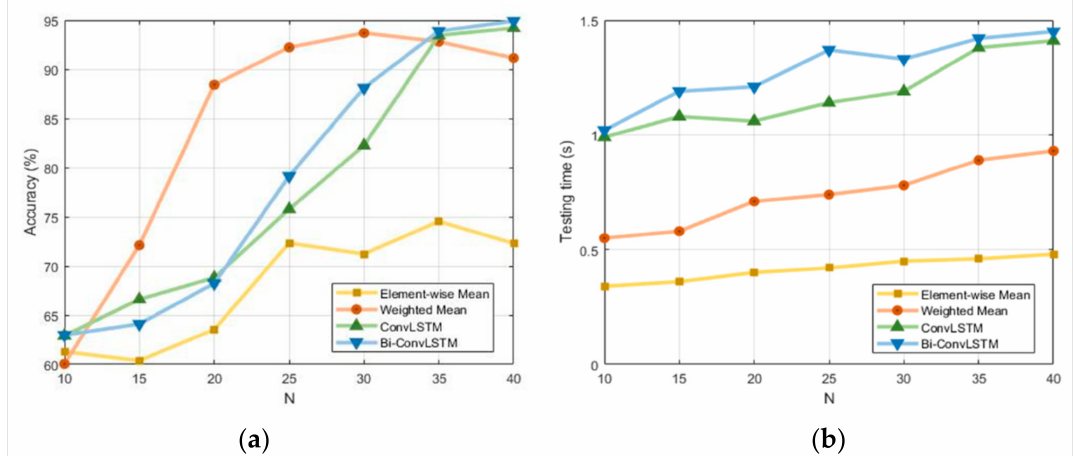
Figure 6. Accuracy and testing time according to frame number of FS N extracted at a random interval: ( a ) accuracy and ( b ) testing